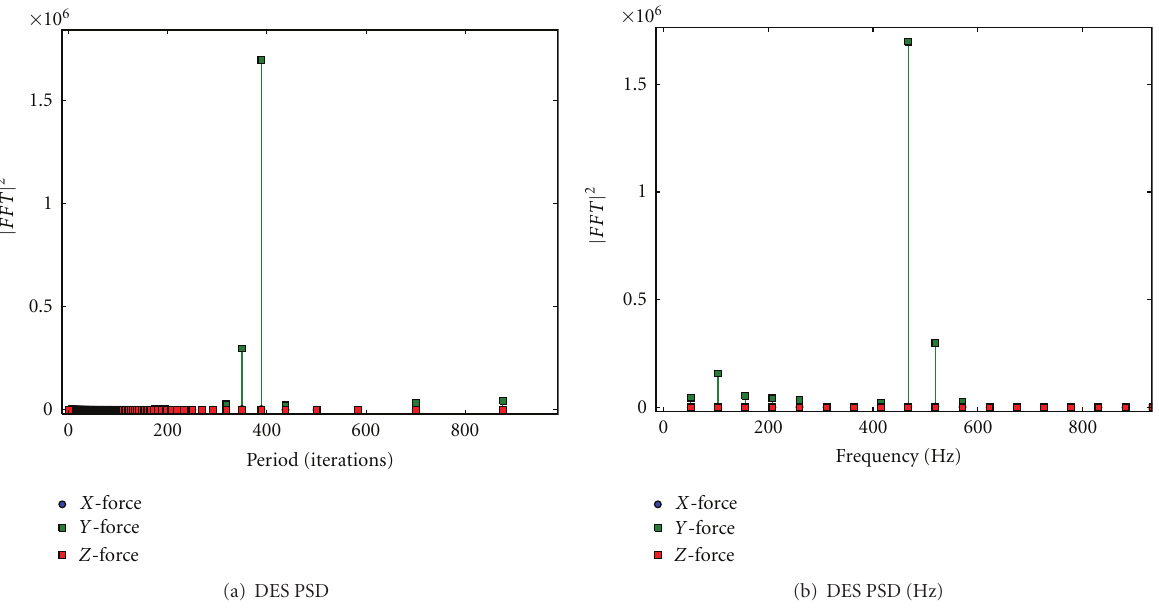
Figure 6: Lift and drag signals for three-dimensional simulation.